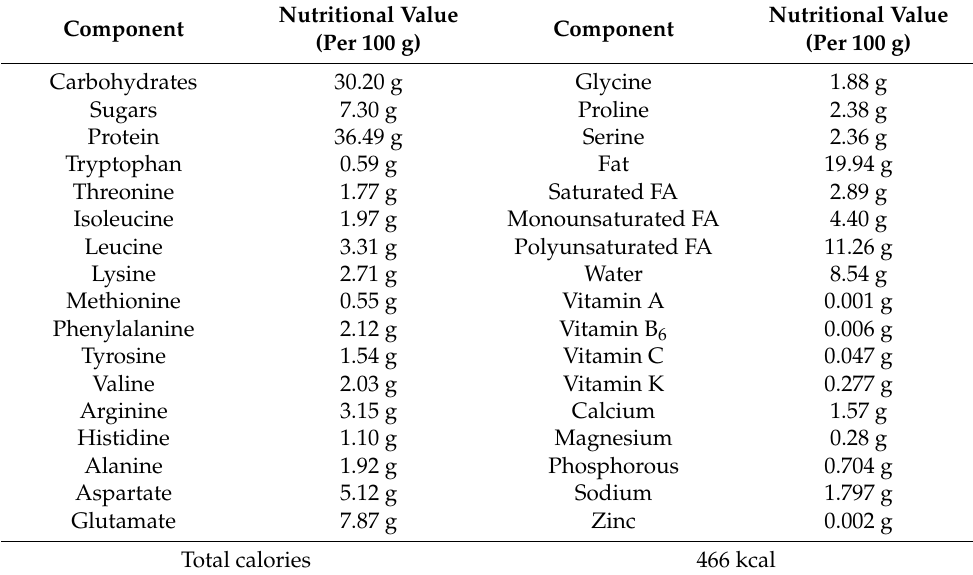
Table 1. Concentration of nutritional components of soybean